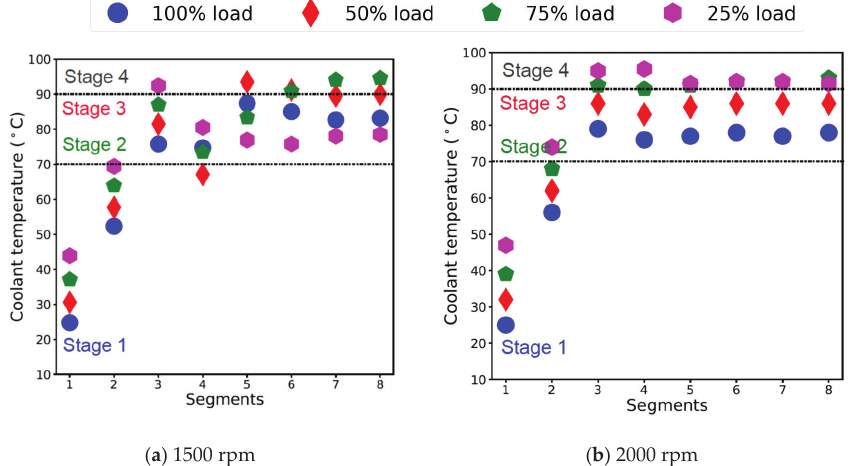
Figure 4. Coolant temperature at each load in each segment at ( a ) 1500 and ( b ) 2000 rpm. The blue circle represents 100% load, the red diamond 50% load, the green pentagon 75% load and the pink hexagon 25% load.